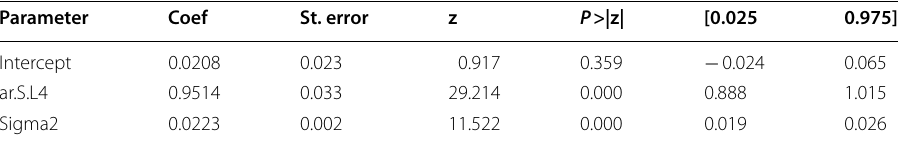
Table 3 Model summary for Amazon revenue